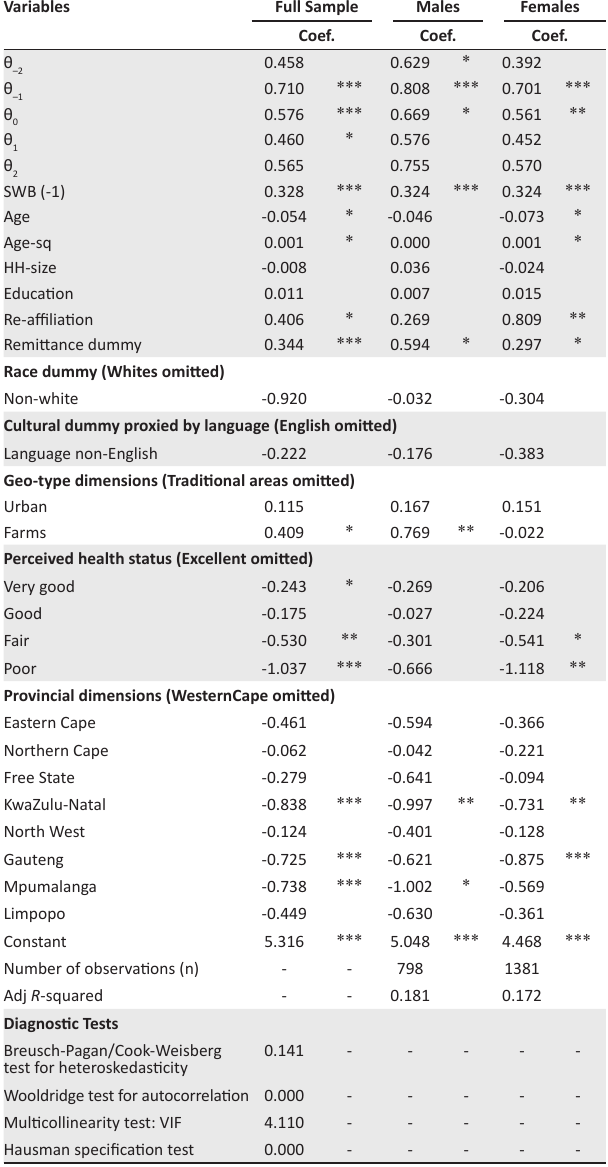
TABLE 3: Fixed effect subjective well-being estimates: Anticipation and adaptation to marriage. Variables